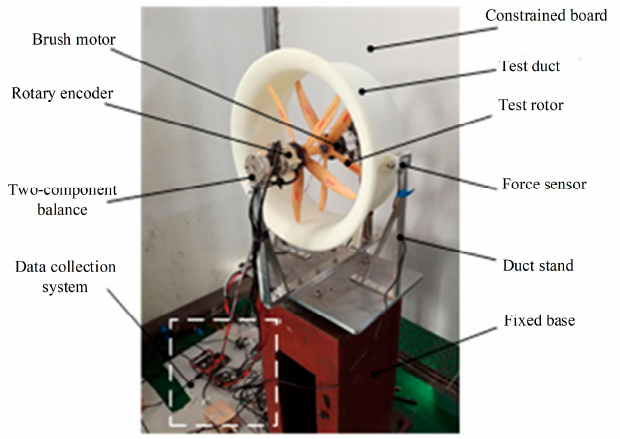
Figure 8. Ducted fan test bench.